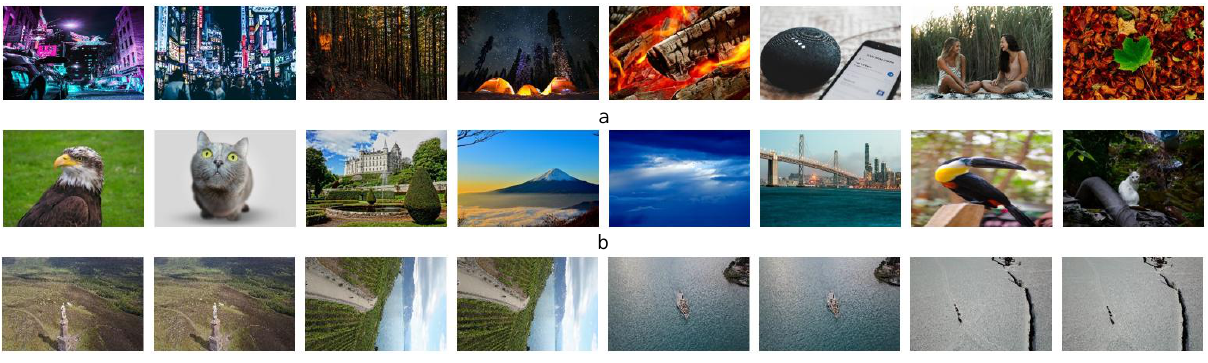
Figure 3 . Datasets for embedding watermarks: a images from the CLIK2019Professonal dataset, b images from the Felicepollano watermarked/not-watermarked-images dataset, c frames from the Drone_Videos dataset.